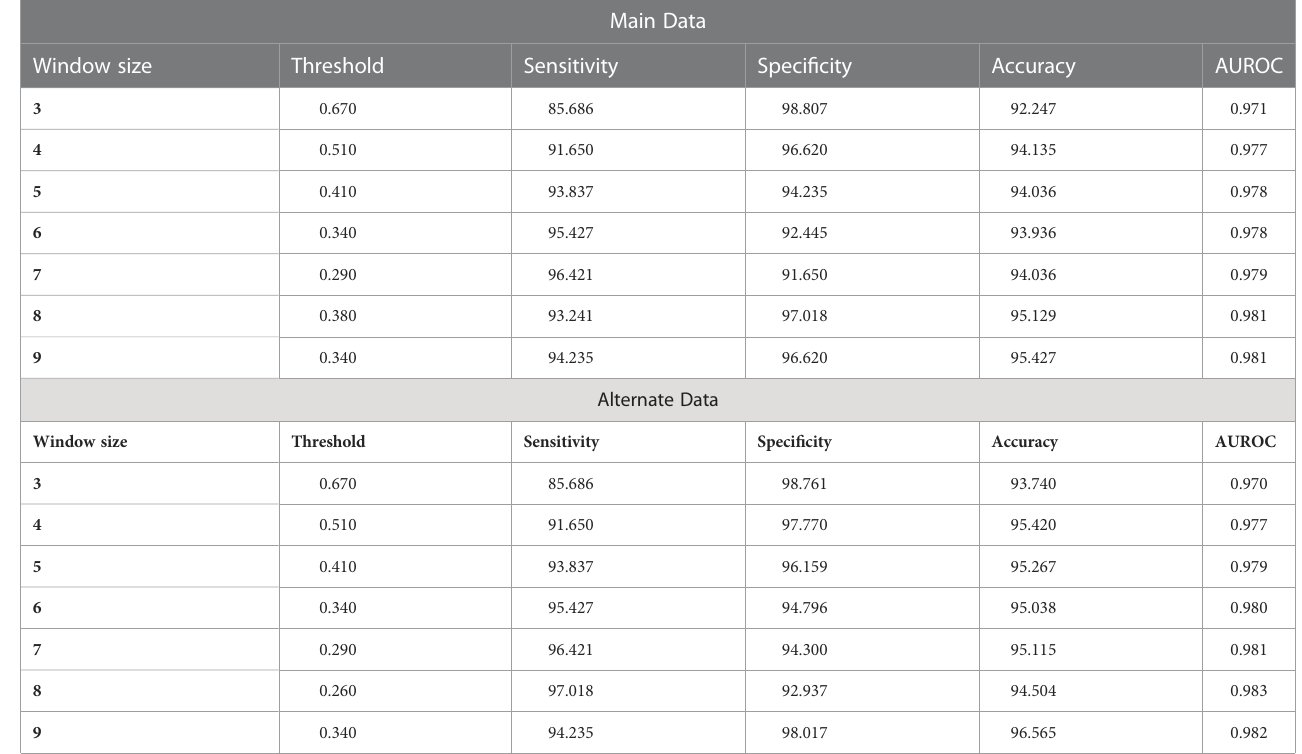
TABLE 3 Performance of the PQ abundance-based method on different window